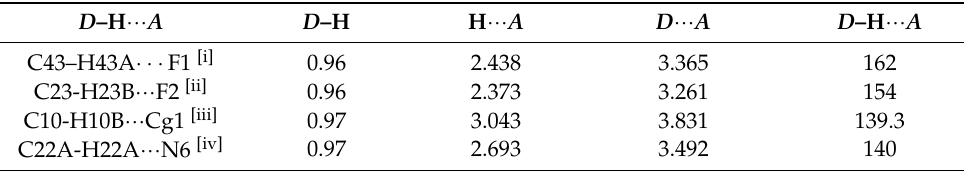
Table 3. Hydrogen-bond geometry (Å, ◦ ) of 2Hg . Cg1 is